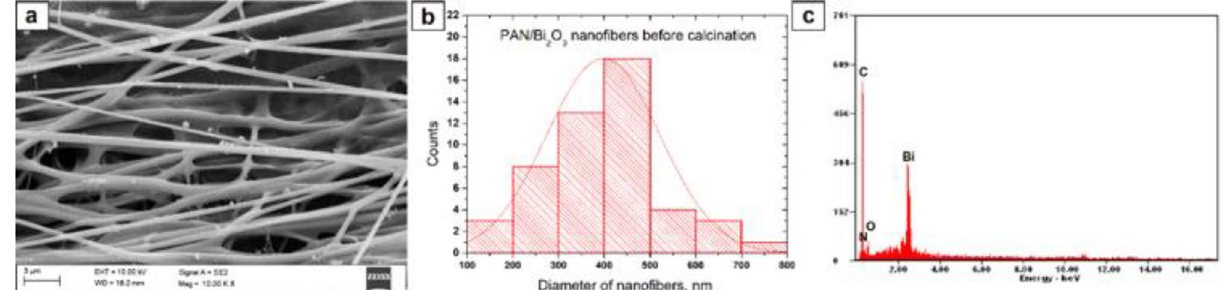
Figure 4. SEM image of the topography on the surface of the formed fibrous PAN/Bi 2 O 3 composite mats ( a ), histogram presenting the distribution of the diameter of randomly selected nanofibers obtained from PAN/ Bi(NO 3 ) 3 · 5H 2 O/DMF solution ( b ), EDS spectra (the strong signal of the C peak, except the signal from the polymer, derive from the substrate on which nanofibers were deposited) from the entire area shown in the SEM images ( c ).